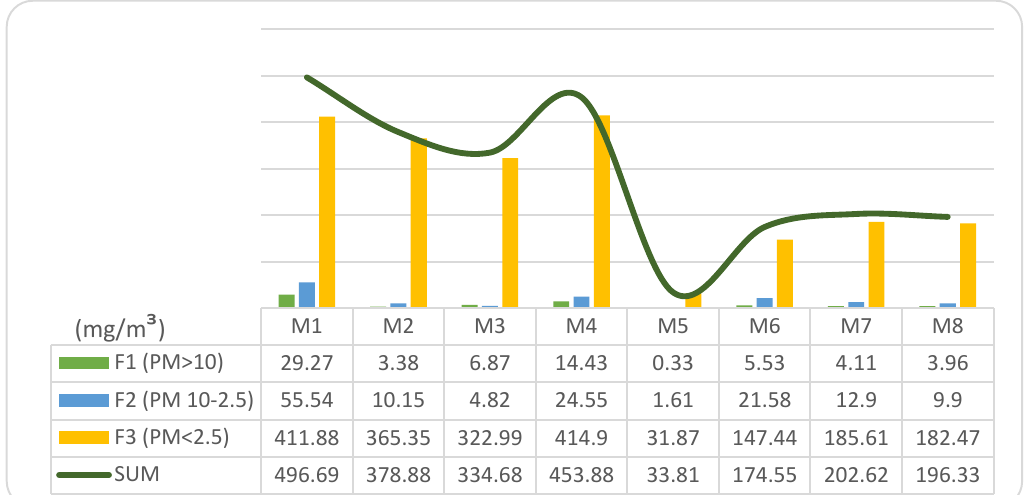
Figure 7. Amount of PM emissions in measurements of variant 2.